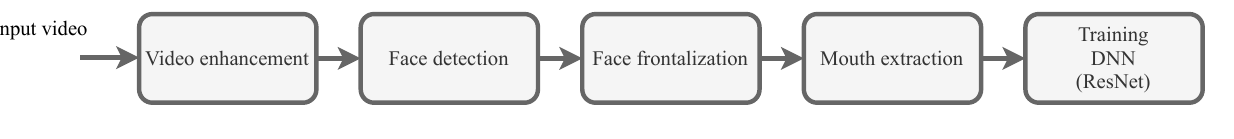
Figure 2. Proposed framework for